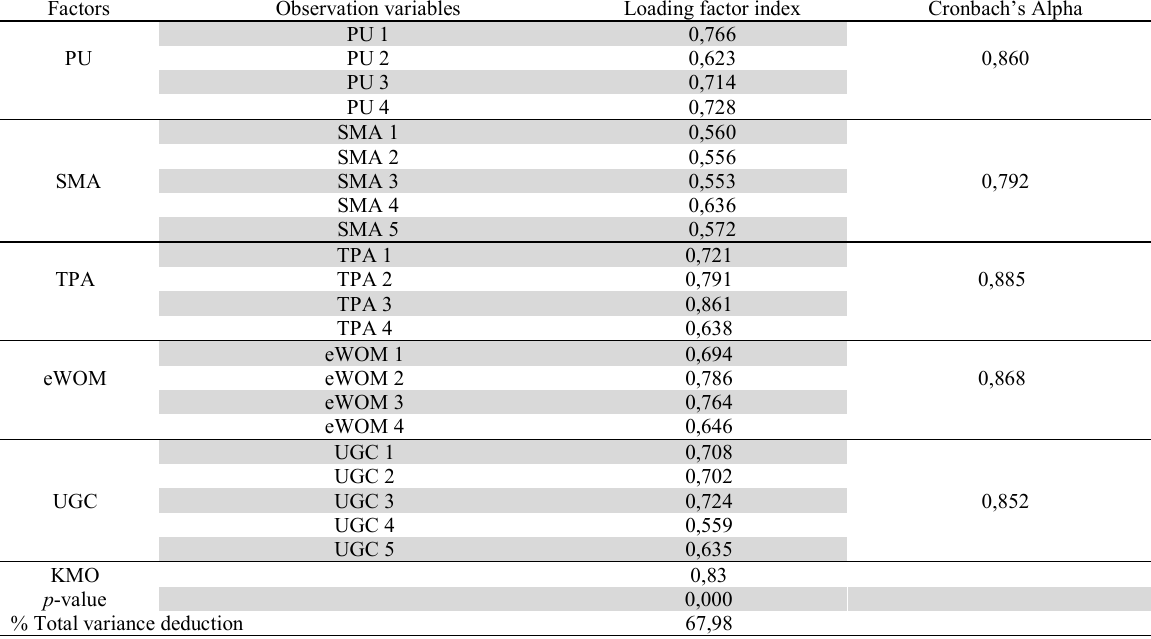
EFA result and testing the reliability of scales